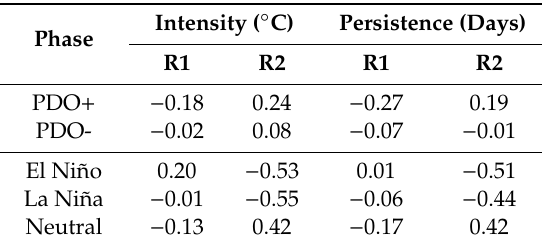
Table 5. Pearson correlation coe ffi cients between the intensity and duration of the heat waves and the ENSO and PDO